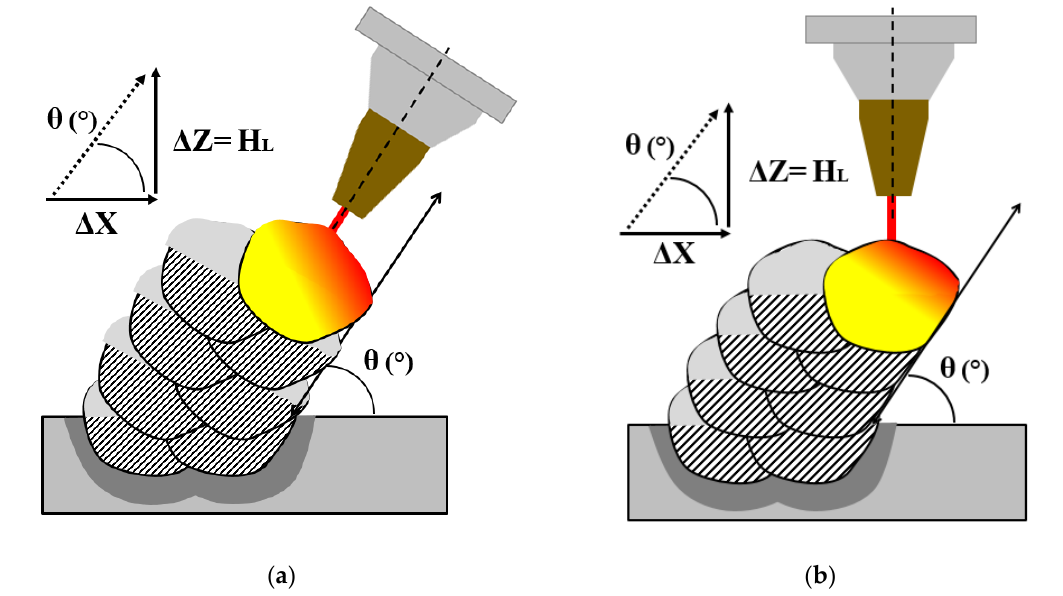
Figure 4. Strategies for the manufacturing of inclined walls: ( a ) Strategy A (4-axis); ( b ) Strategy B (3-axis).